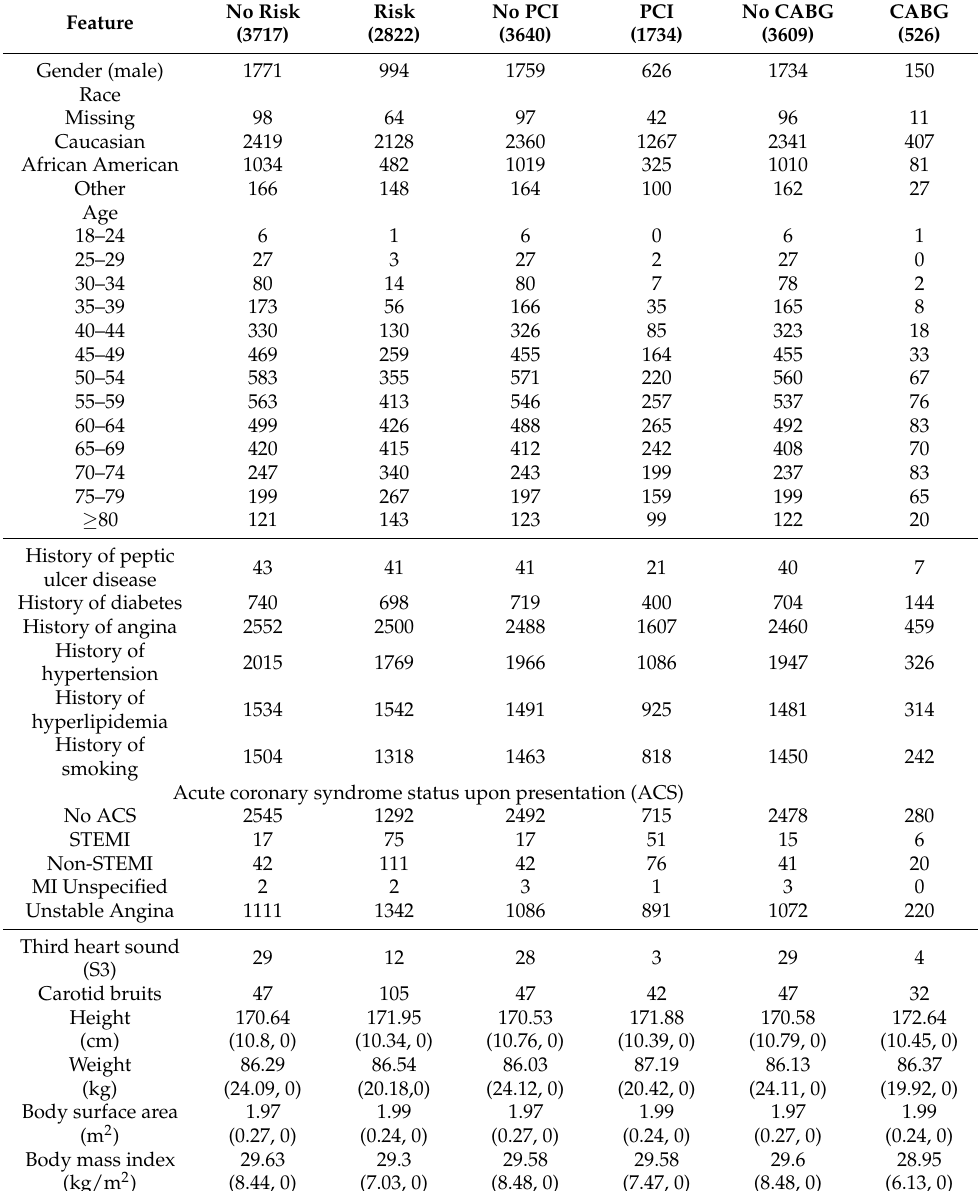
Table A1. Univariance analysis of patient